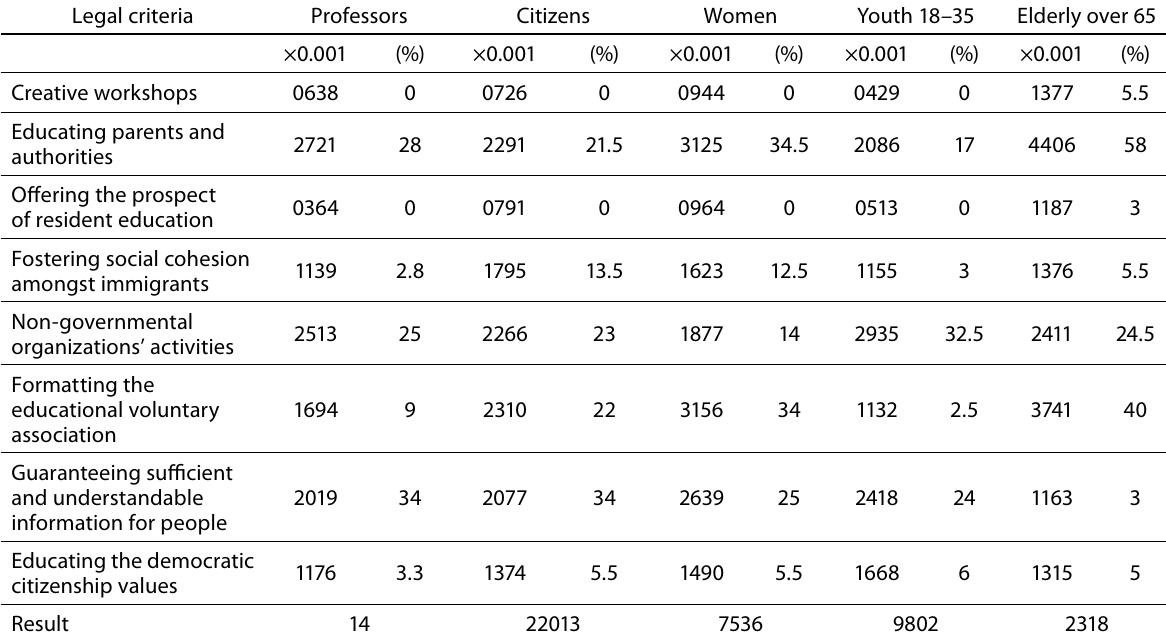
Table 4. analyzing the Serving Its Inhabitants